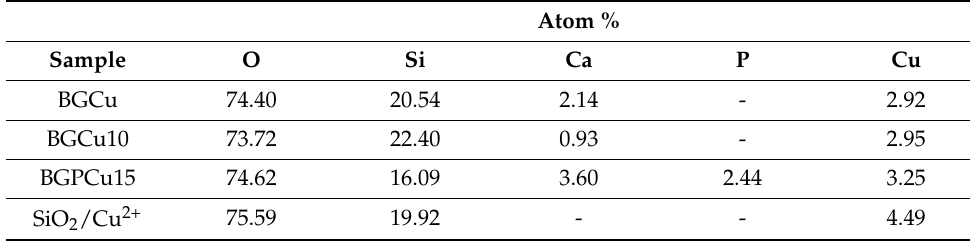
Table 3. EDX analysis of the samples with Cu.